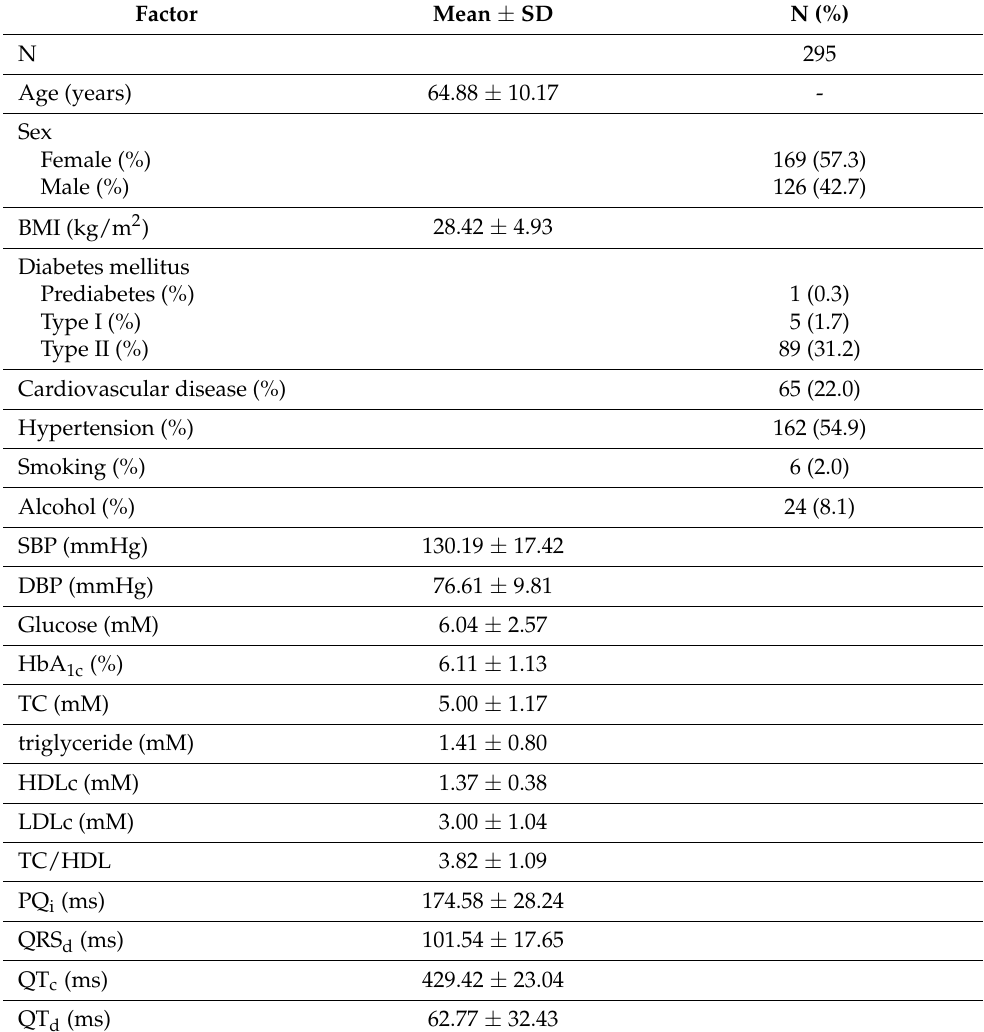
Table 1. Baseline characteristics of the Australian rural population. Demographic, blood biochemistry, blood pressure, and ECG